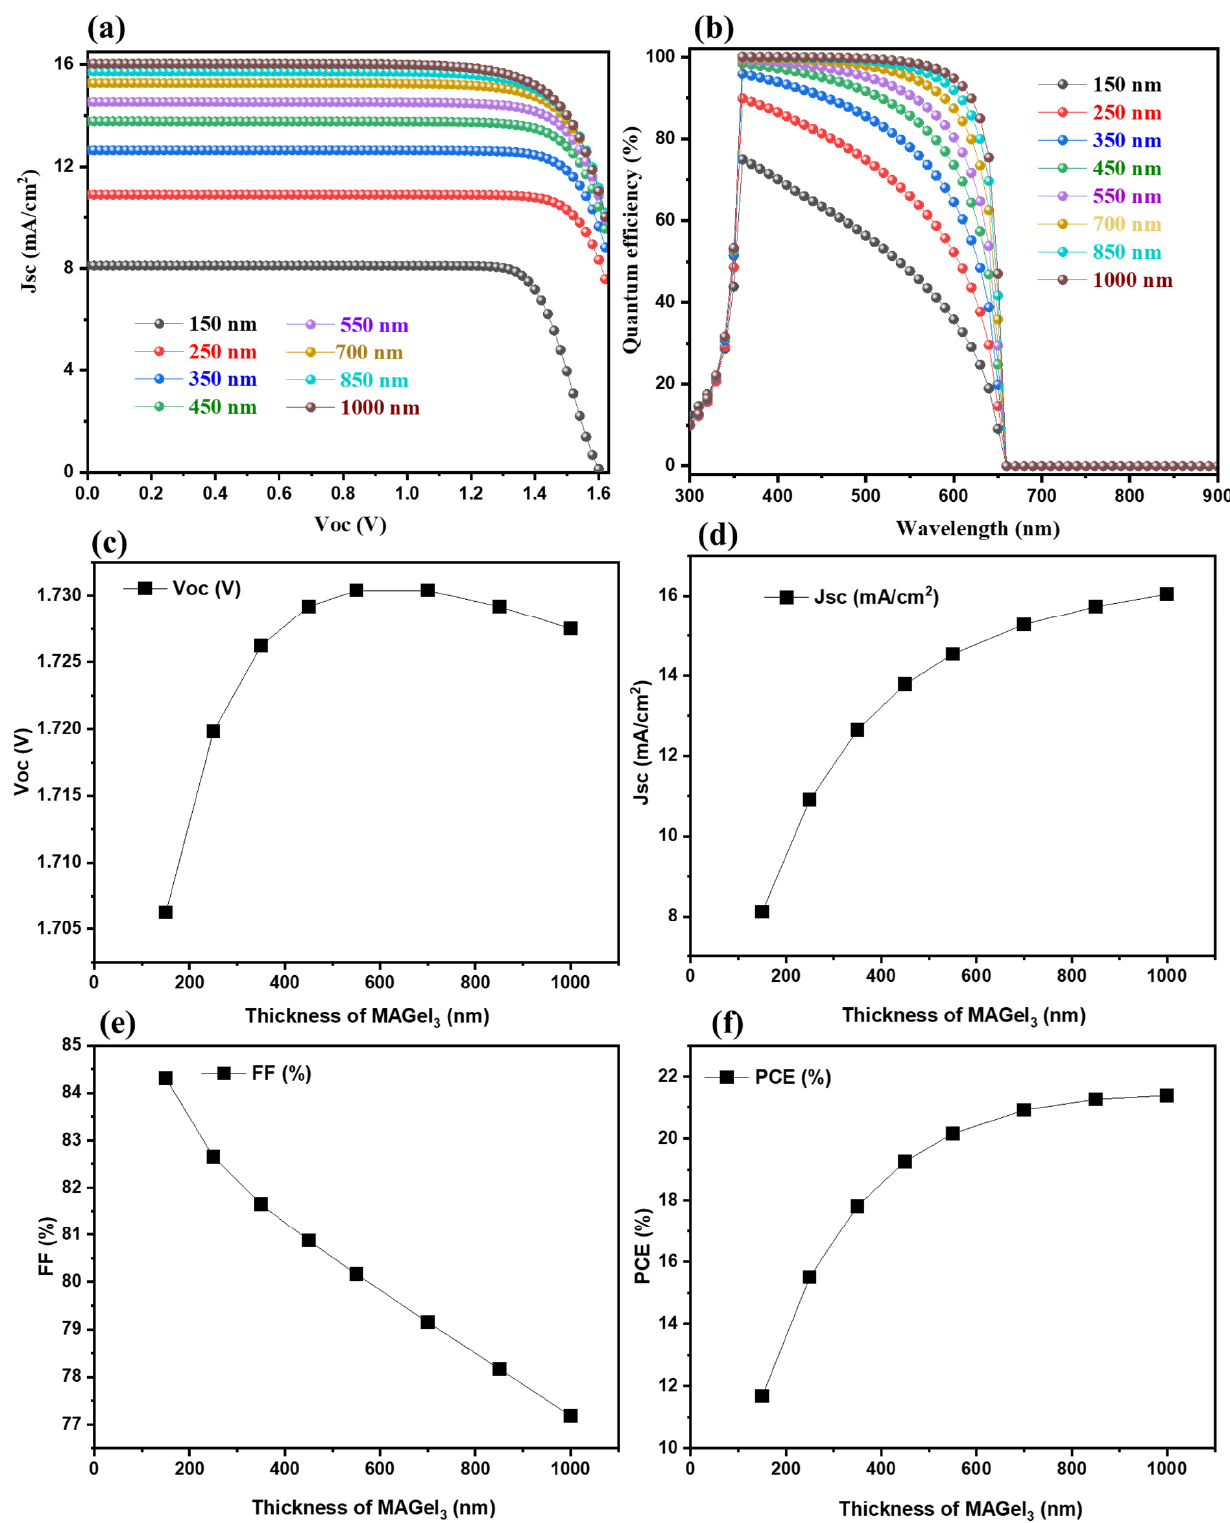
Figure 3. J-V curves ( a ) and EQE curves ( b ) of the simulated PSCs (FTO(500 nm)/SnO 2 (100 nm)/MAGeI 3 (150–1000 nm)/spiro-OMeTAD(100 nm)) at 300 K. Extracted Voc ( c ), Jsc ( d ), FF ( e ), and PCE ( f ) of the simulated PSCs (FTO(500 nm)/SnO 2 (100 nm)/MAGeI 3 (150–1000 nm)/spiro-OMeTAD(100 nm)) at 300 K.